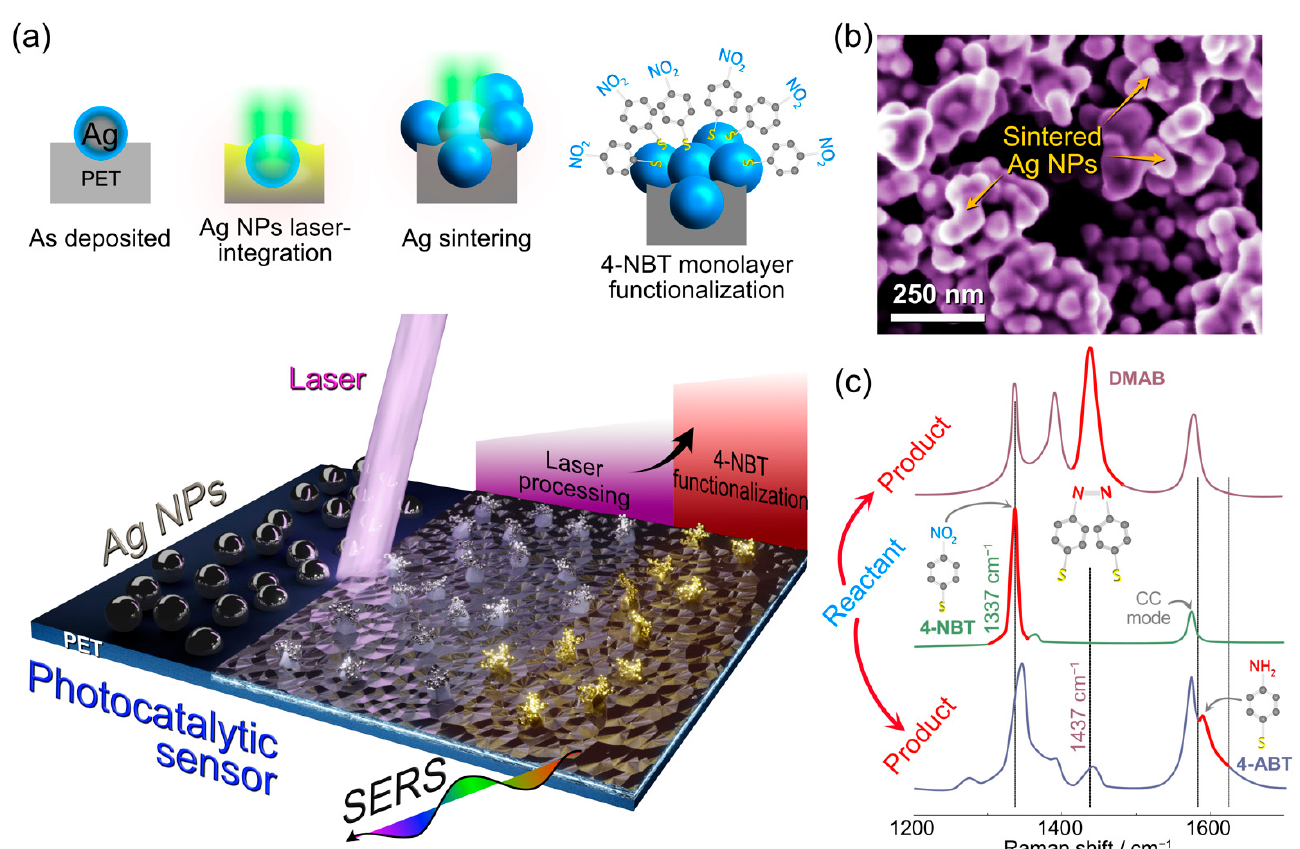
Figure 1. ( a ) Schematic concept of the 3D molecular plasmon-active structures. A thin film of Ag NPs is integrated into the polymer substrate by laser processing. The resulting three-dimensional Ag microforests are then functionalized by self-assembled monolayers of 4-NBT. ( b ) SEM top-view image of AgLIMPc showing the surface of the silver/PET composite. The inset SEM image was obtained from the top of a sample with closely spaced Ag nanostructures into clusters forming plasmon-active hotspots. ( c ) Characteristic spectra of the 4-NBT Raman probe and the main vibration modes of the different species (4-ABT and DMAB) can evolve during SERS. All spectra in ( c ) were drawn from actual experimental results.